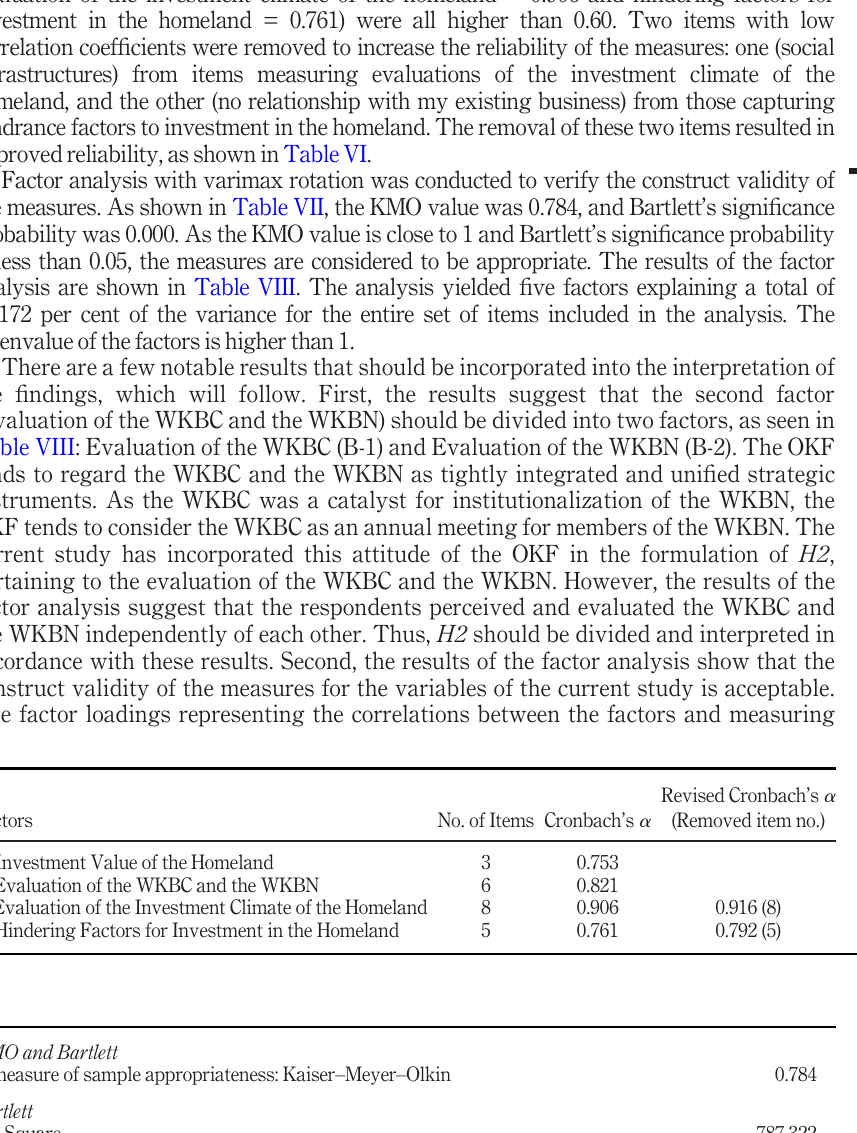
Table VII. Validity of